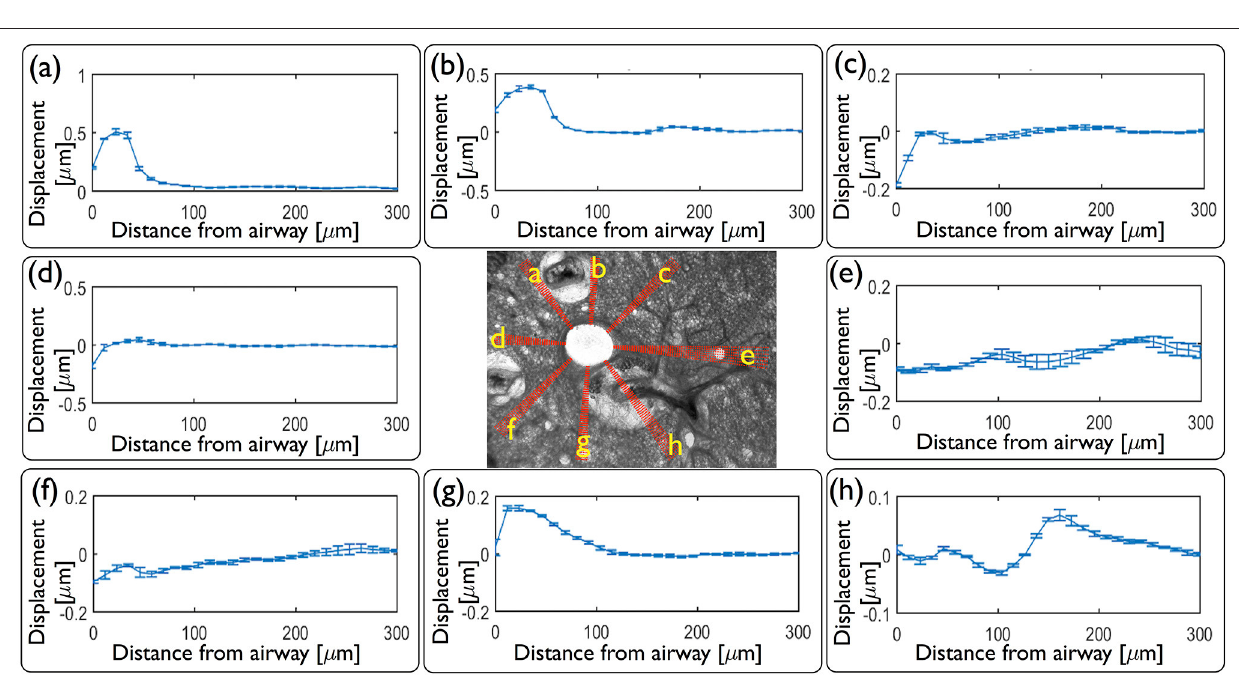
about 1 min after addition of the contractile agonist, and essentially manifests as a radial expansion and a circumferential compression. In the radial direction, a sharp drop in strain is